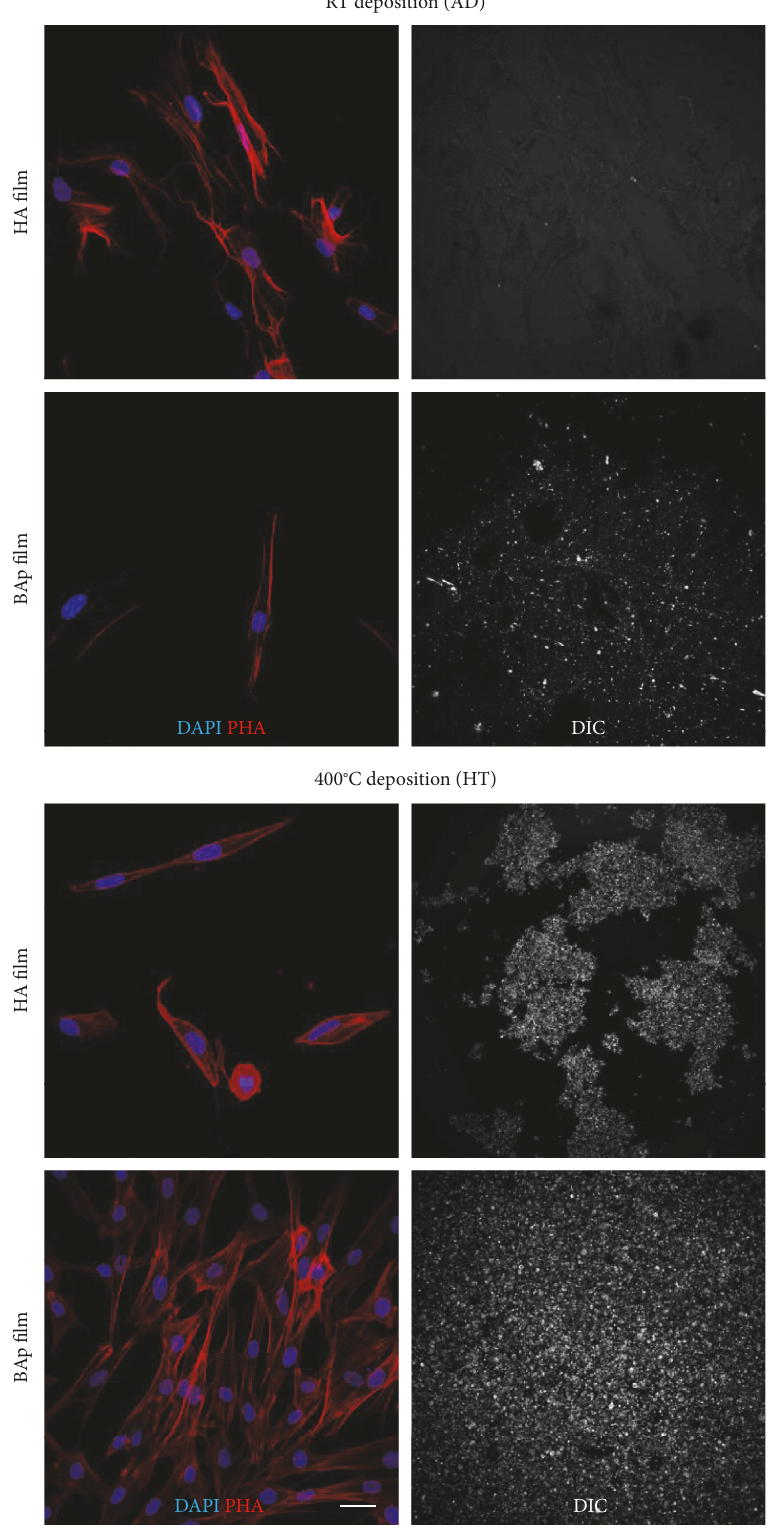
Figure 3: Representative immuno fl uorescence images showing cell morphology of hDPSCs cultured on HA and BAp fi lms and DIC images representing fi lm adhesion to the underlying surface at 7 days of culture. Immuno fl uorescence analysis was performed against phalloidin. Nuclei were counterstained with DAPI. Scale bar: 10 μ